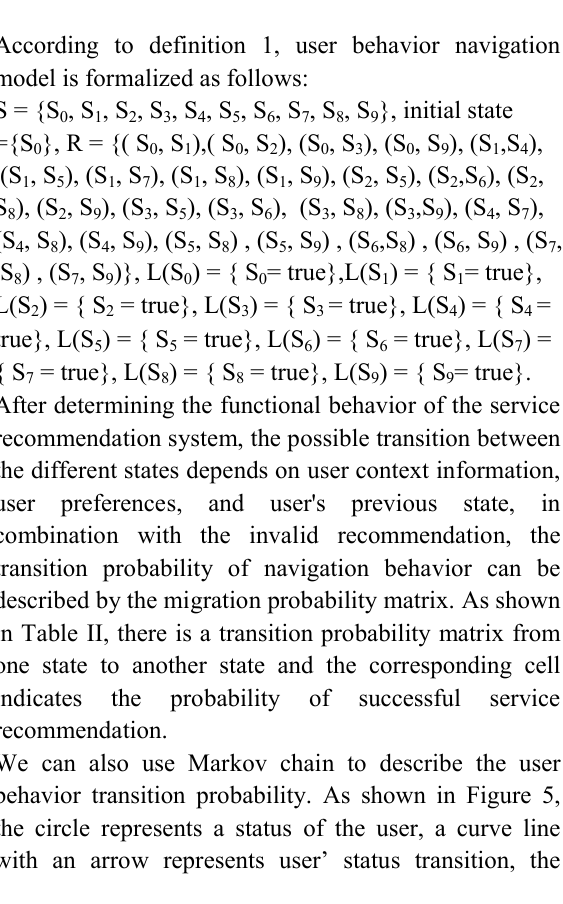
Table 2. The migration probability matrix